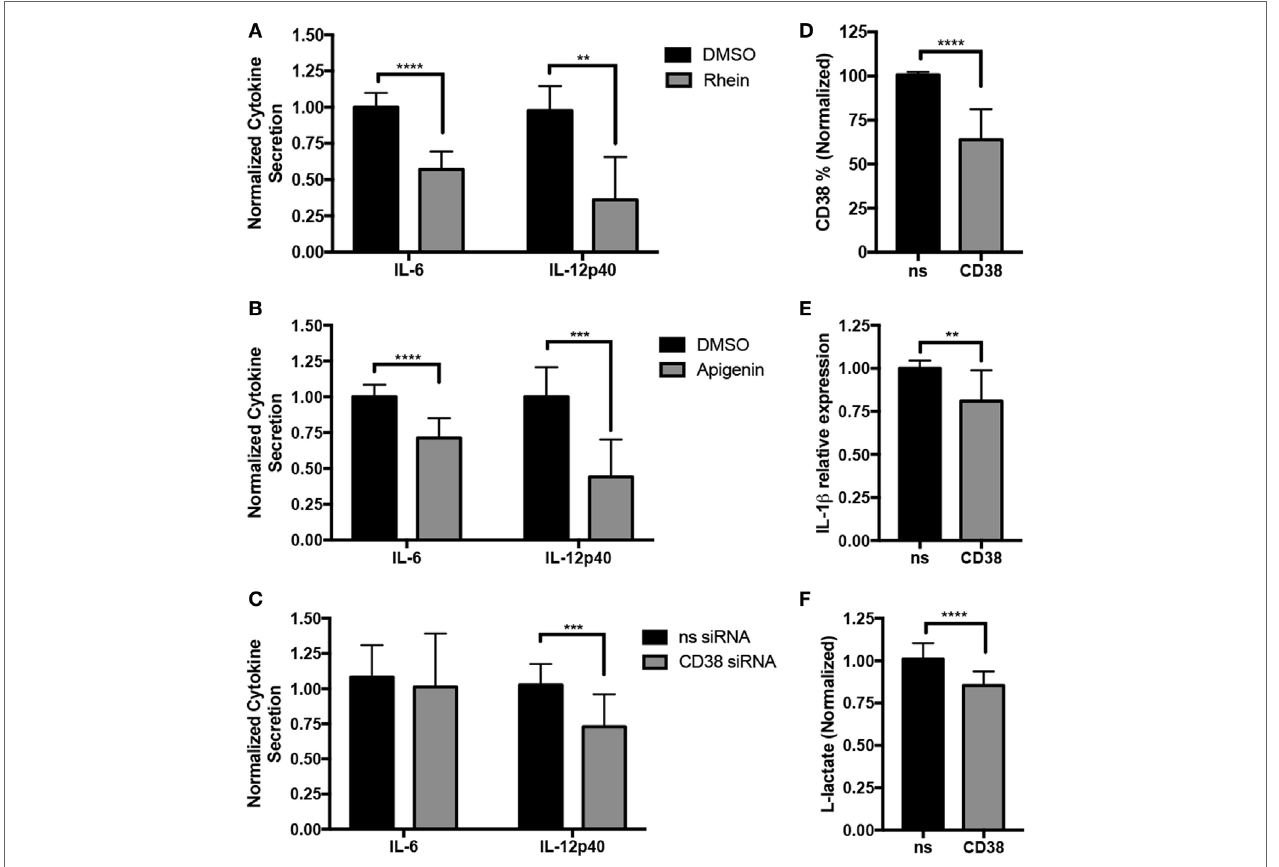
FigUre 3 | CD38 promotes inflammatory cytokine secretion in human macrophages. Human monocyte-derived macrophages (MDMs) were treated with 15 µM rhein or DMSO control (a) , 25 µM apigenin or DMSO (B) , or transfected with 100 µM CD38 siRNA cocktail or siRNA control (c) on day 5. On day 6, they were activated with LPS + IFN- γ for an additional 24 h prior to analysis. (a–c) IL-6 and IL-12p40 secretion was analyzed by ELISA from MDM supernatants. Graphs pool normalized (relative to corresponding experiment vehicle control or nonsense siRNA) data from three (a) , five (B) , or six (c) independent experiments/donors, with at least two technical replicates for each sample. Data are expressed as mean cytokine secretion ± SD relative to vehicle condition. (D) Quantification of CD38 + cells analyzed by flow cytometry from MDM transfected with control or CD38 siRNAs for data shown in panel (c) is expressed as percent of cells ± SD, n = 6 independent experiments/donors and two technical replicates per sample. (e) Quantification of IL-1 β + MDMs analyzed by flow cytometry for data shown in panel (c) is expressed as percent of cells ± SD, n = 6 independent experiments/donors and two technical replicates per sample. (F) l -Lactate assays run using supernatants from panel (c) , n = 5 independent experiments/donors, with at least three technical replicates per sample. All data were analyzed by unpaired t tests. ** p < 0.01, *** p < 0.001, **** p <